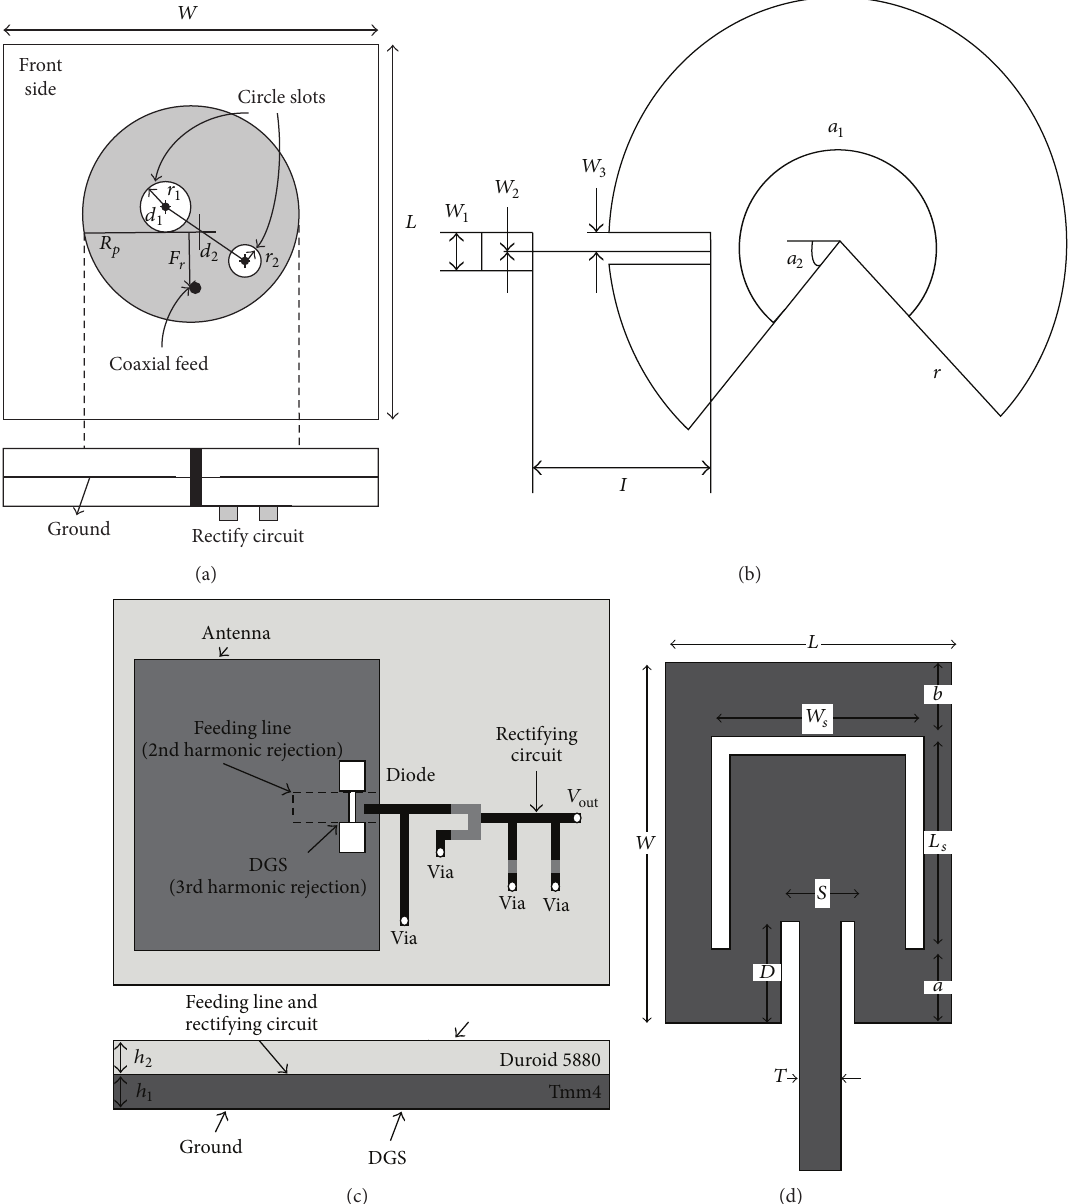
Figure 4: Various antenna designs for harmonic